Question: Briefly state, in one sentence, what is plotted here.
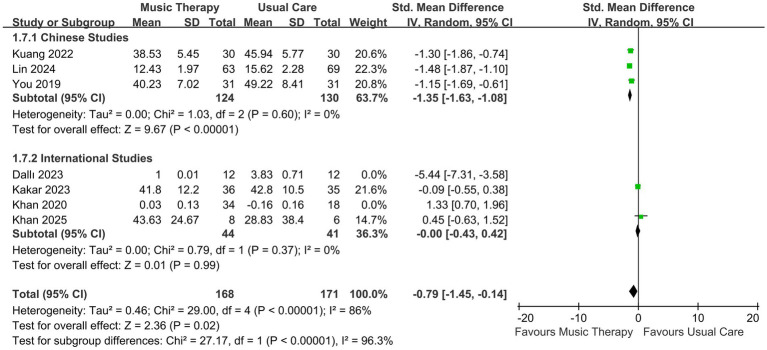
Answer: Forest plot of sensitivity and subgroup analysis for anxiety.